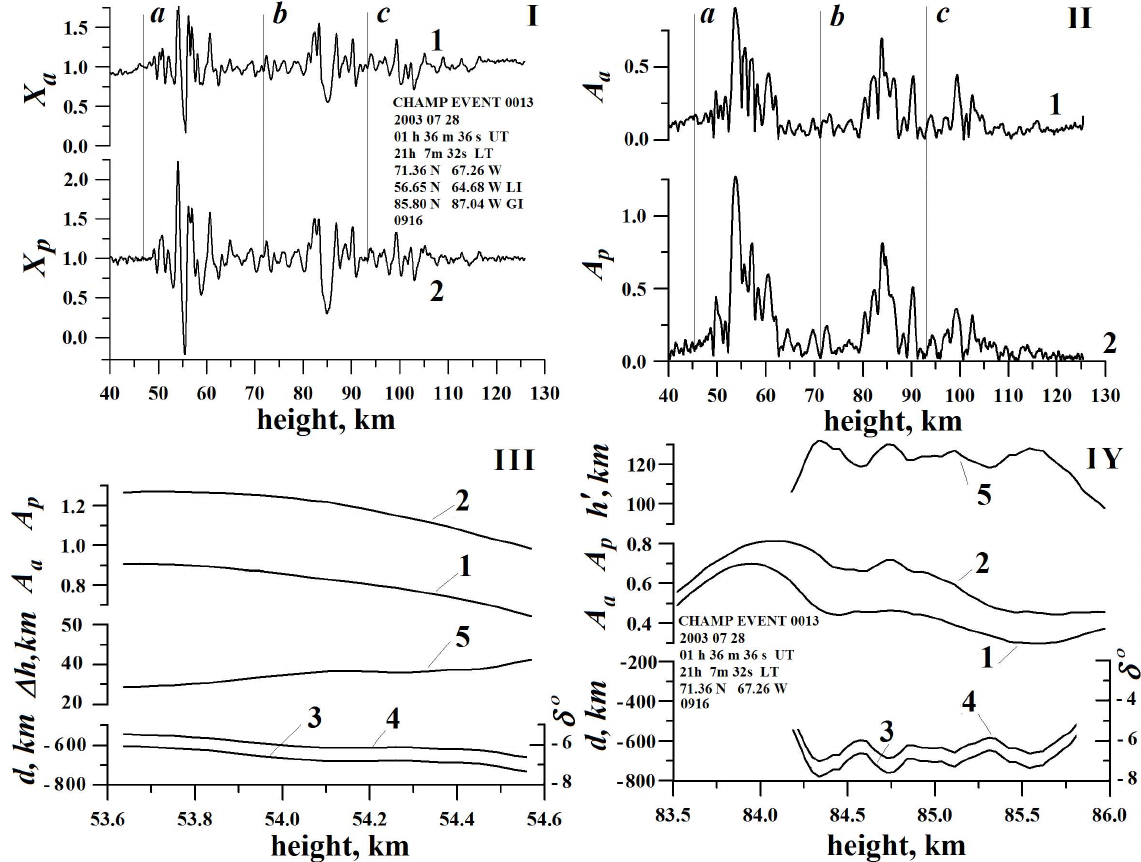
Fig. 10. I. Comparison of the refractive attenuations X a ,X p found from the RO intensity and eikonal data at GPS frequency f 1 (curves 1 and 2, respectively). II. The amplitudes of analytical signals corresponding to the variations of the refractive attenuations X a ,X p (curves 1 and 2). III. Location of the first layer using amplitudes A a ,A p . IY. Location of the second layer using amplitudes A a ,A p